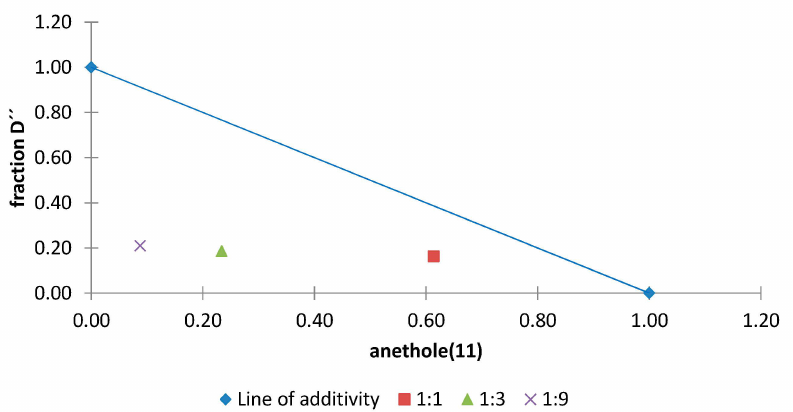
Figure 15. Normalized isobologram (ED 50 ) for the complex mixture anethole ( 11 )/fraction D 11 (from the acetone extract) in the etiolated wheat coleoptile bioassay. (Combination ratios 1:1; 1:3; 1:9). The mixture with a 1:1 ratio did not show a significant difference on applying Student’s t test and this indicates an additive effect. The 1:3 and 1:9 ratios are located below the line of additivity and significant differences were observed on applying Student’s t test, thus indicating a synergistic effect.